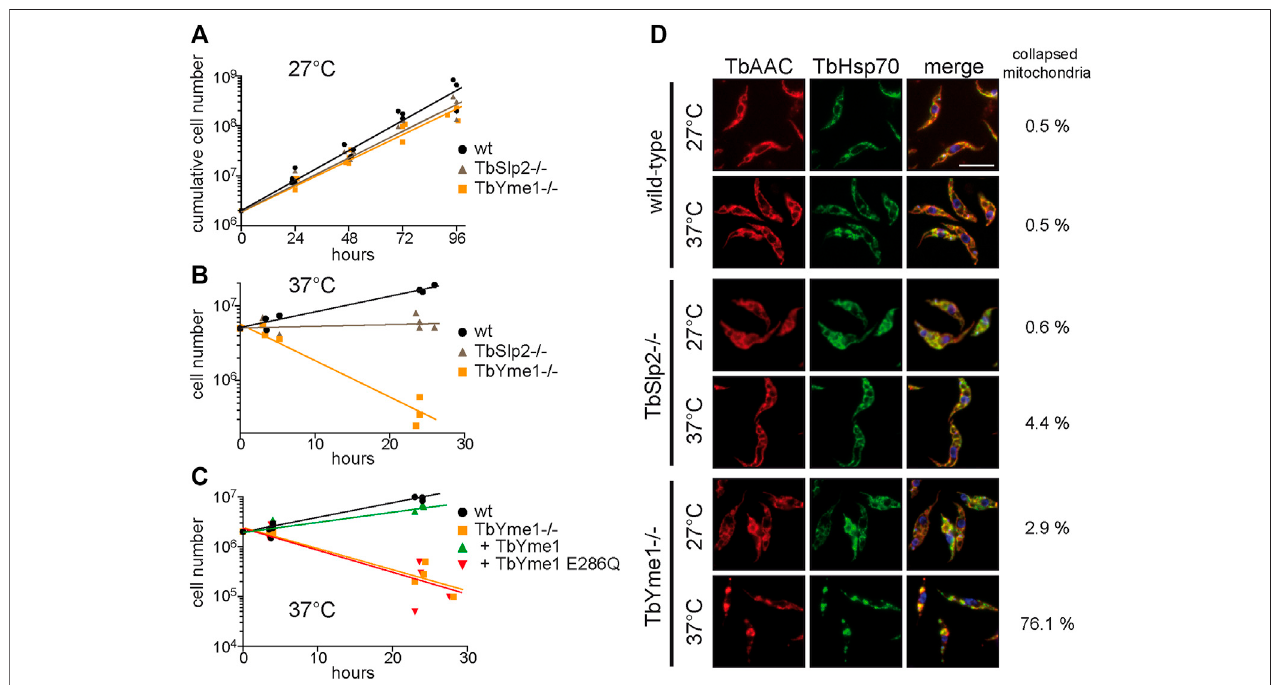
FIGURE5| TbYme1isrequired forheatstresstolerance. (A) Growthcurvesofwild-type,TbSlp2 − / − andTbYme1 − / − parasitescultured at27 ° C. (B) Cellnumbers of wild-type, TbSlp2 − / − and TbYme1 − / − parasites cultured at 37 ° C for a total period of 24 h. (C) Wild-type, TbYme1 − / − and TbYme1 − / − parasites re-expressing TbYme1orTbYme1E286Qweredilutedtothesamedensityandculturedat37 ° C.Cellnumbersweredeterminedatdifferenttimepoints. (D) Mitochondrialmorphology of wild-type, TbSlp2 − / − and TbYme1 − / − parasites was assessed by immuno fl uorescence microscopy using TbAAC and TbHsp70 antibodies. Parasites were cultured at 27 ° C or at 37 ° C for 4 h, fi xed and processed for microscopy. Mitochondria were visually categorized as reticulate or collapsed based on the appearance of large mitochondrial aggregates. Numbers of parasites with collapsed mitochondria are given next to the images (n > 100). Scale bar: 10